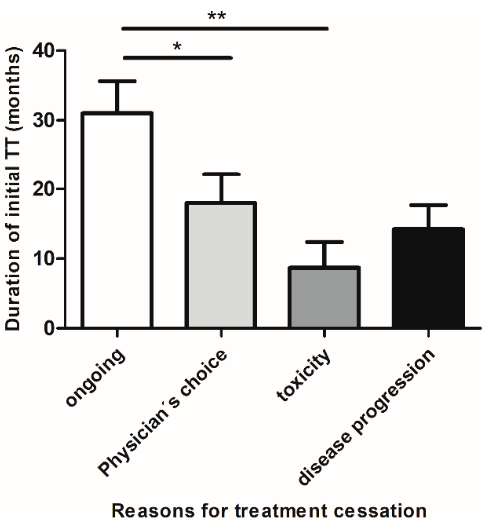
Figure 2. Duration of BRAF/MEKi therapy in patients who obtained CR and either maintained treatment or discontinued TT for various reasons. Patients who discontinued first-line BRAF ± MEKi treatment due to treatment-associated toxicities (mean duration ± SEM: 8.7 ± 3.7 months) or due to disease progression (mean ± SEM: 14.2 ± 3.4 months), received therapy for a shorter time period